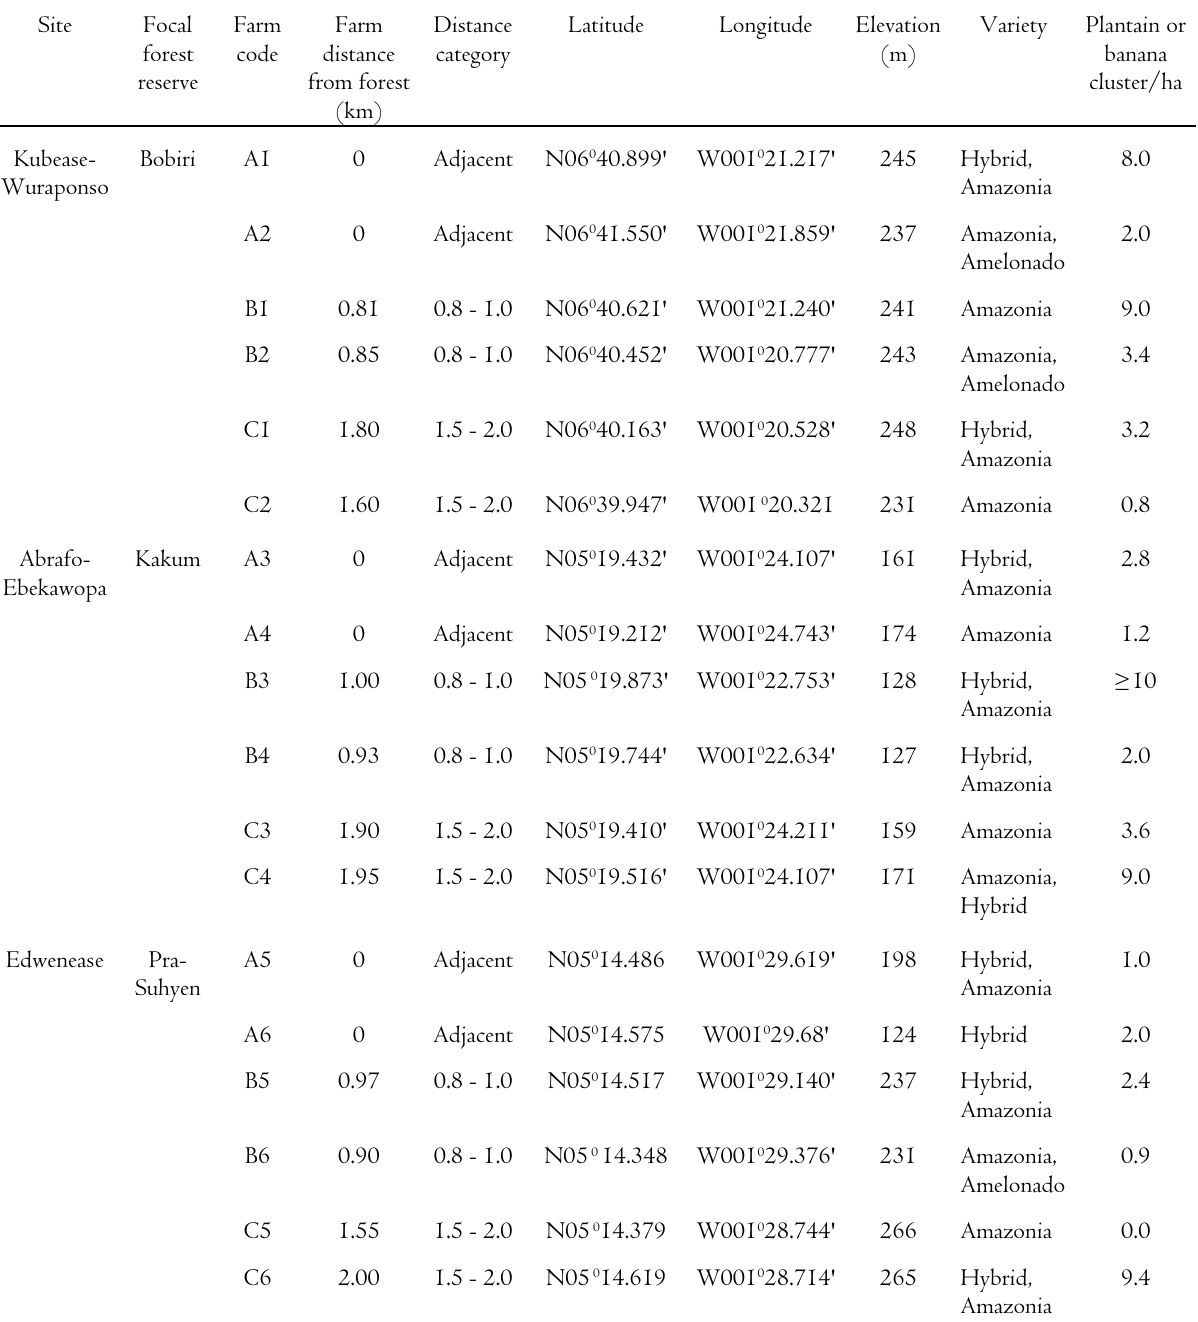
T ABLE 1: Characteristics of the experimental cocoa